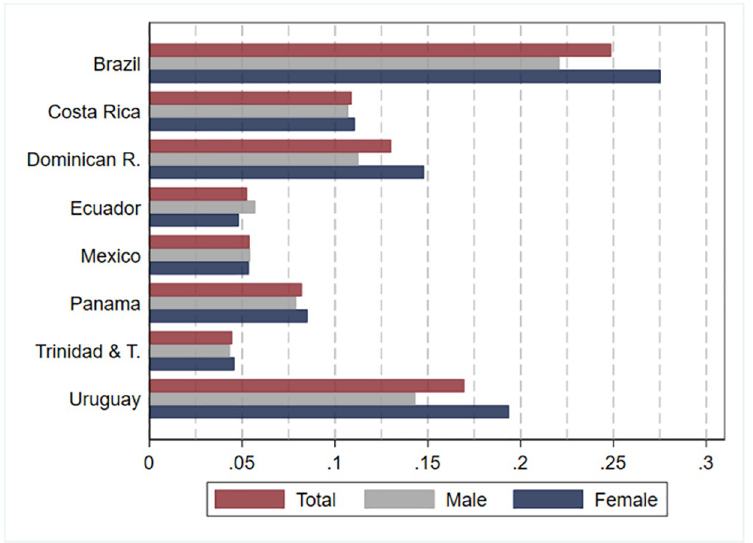
Fig 1. Prevalence of disability: Estimates by country and sex. Source: authors’ estimations based on data provided by [10] from censuses collected by National Statistics Offices in each country. Estimates for Brazil, Dominican Republic, Ecuador, Mexico, and Panama refer to the year 2010. Estimates for Costa Rica, Trinidad and Tobago, and Uruguay refer to the year 2011. Estimates consider individuals aged 3 and older. https://doi.org/10.1371/journal.pone.0258825.g001 answer. Using this definition of disability, prevalence rates fall to 6.9 percent in Brazil (2010), 5